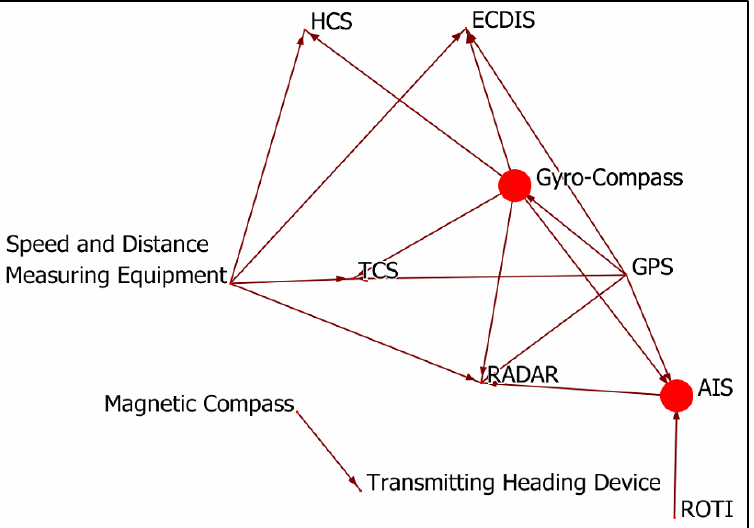
Figure 1. Graph on dependency of INS components.